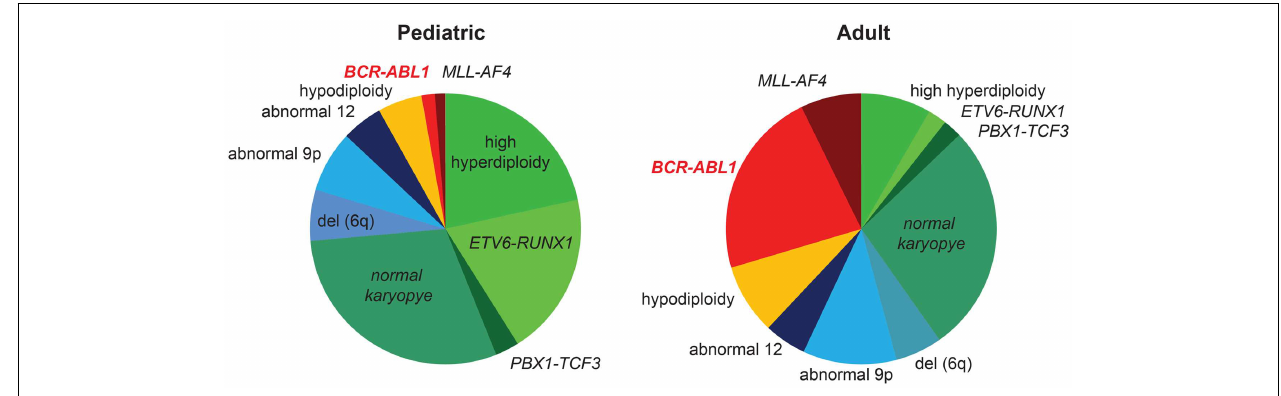
unfavorable cytogenetics are represented in yellow/red. Favorable cytogenetics (high hyperdiploidy, ETV6–RUNX1 ) decrease, while the frequency of BCR/ABL1 rearrangement increases with age.The higher percentage of unfavorable cytogenetics substantially contributes to inferior outcomes in adult versus pediatric